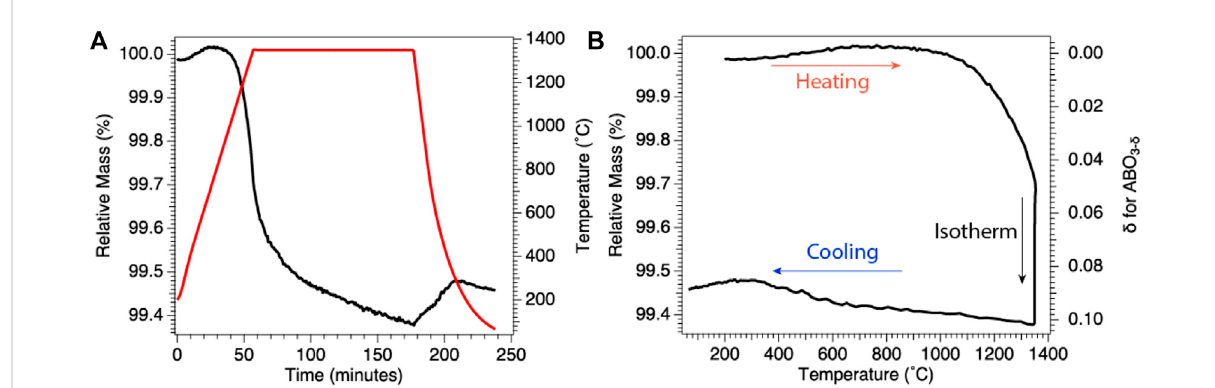
FIGURE 2 Results of representative BCM thermogravimetric analysis under reducing conditions. (A) Change in relative mass (black), instantaneous mass/ initial mass, with temperature (red), demonstrating mass loss during 1,350 ° C isothermal reduction. (B) Relative mass from (A) plotted as a function of temperature (left axis) and with relative mass transformed into oxygen off-stoichiometry, δ (inverted right axis), for BCM. Results demonstrate quenching of a known reduced state for subsequent ex situ